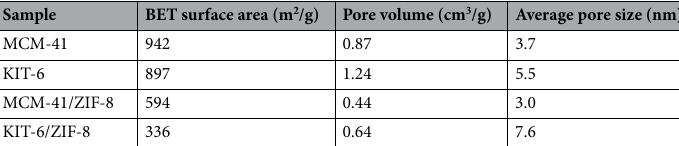
Table 1. Textural and structural properties.